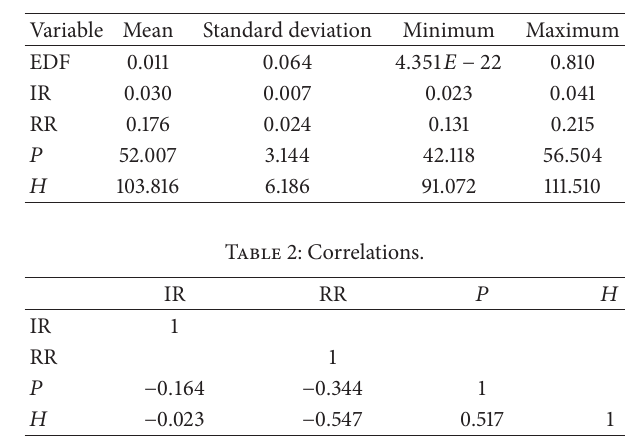
Table 1: Descriptive statistics.